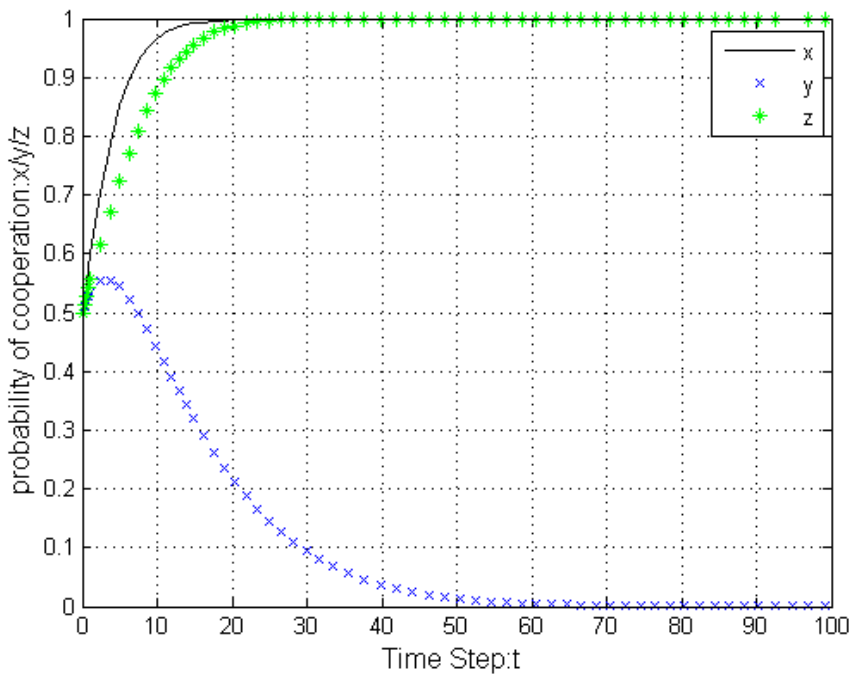
Figure 8. Evolution simulation, Scenario 8.